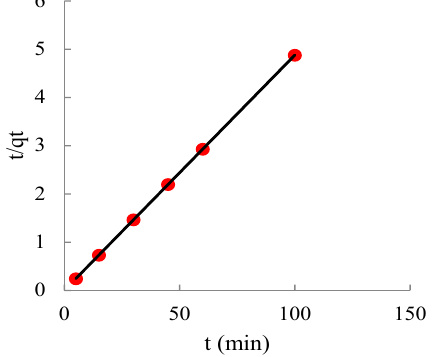
Fig. 14: Second-order plot of cadmium adsorption onto polypyrrole/titanium dioxide nanocomposite.